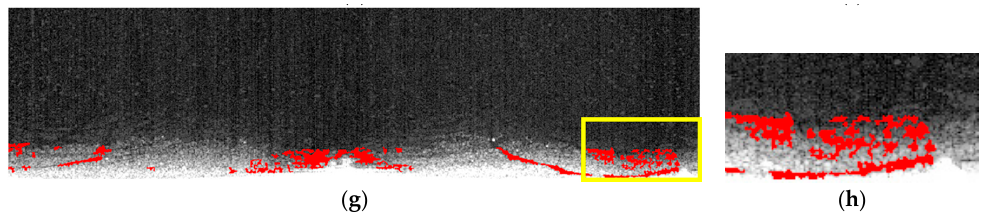
Figure 17. Comparing oil spill detection by three methods: ( a ) original image; ( b ) enlarged version of the highlighted area in ( a ); ( c ) oil spills detected using the method proposed by Zhu et al.; ( d ) enlarged version of the highlighted area in ( c ); ( e ) oil spills detected using the method proposed by Bradley et al.; ( f ) enlarged version of the highlighted area in ( e ); ( g ) oil spills detected using the improved adaptive enhancement; and ( h ) the enlarged version of the highlighted area in ( g ).